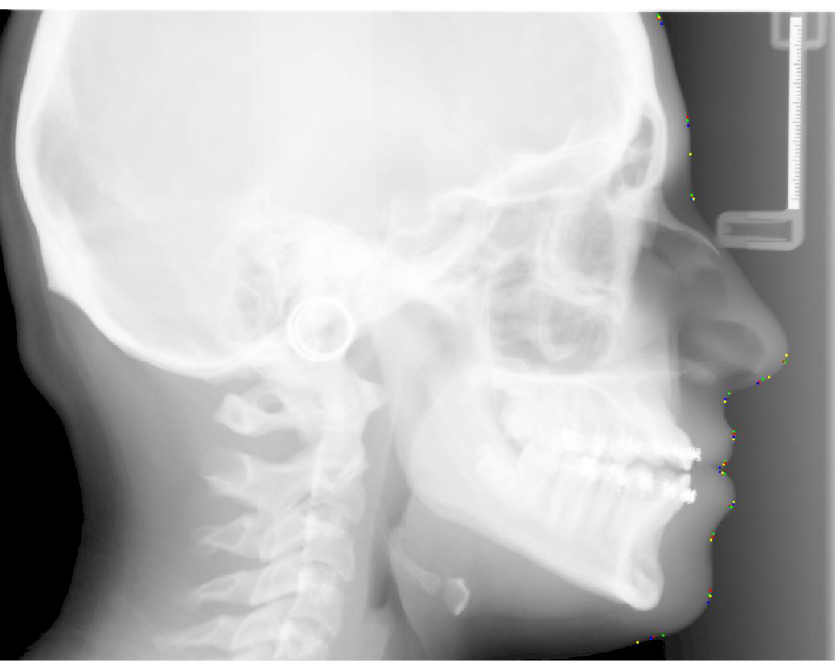
Figure 6. Graphical representation of variations of one sample image showing all the landmarks.